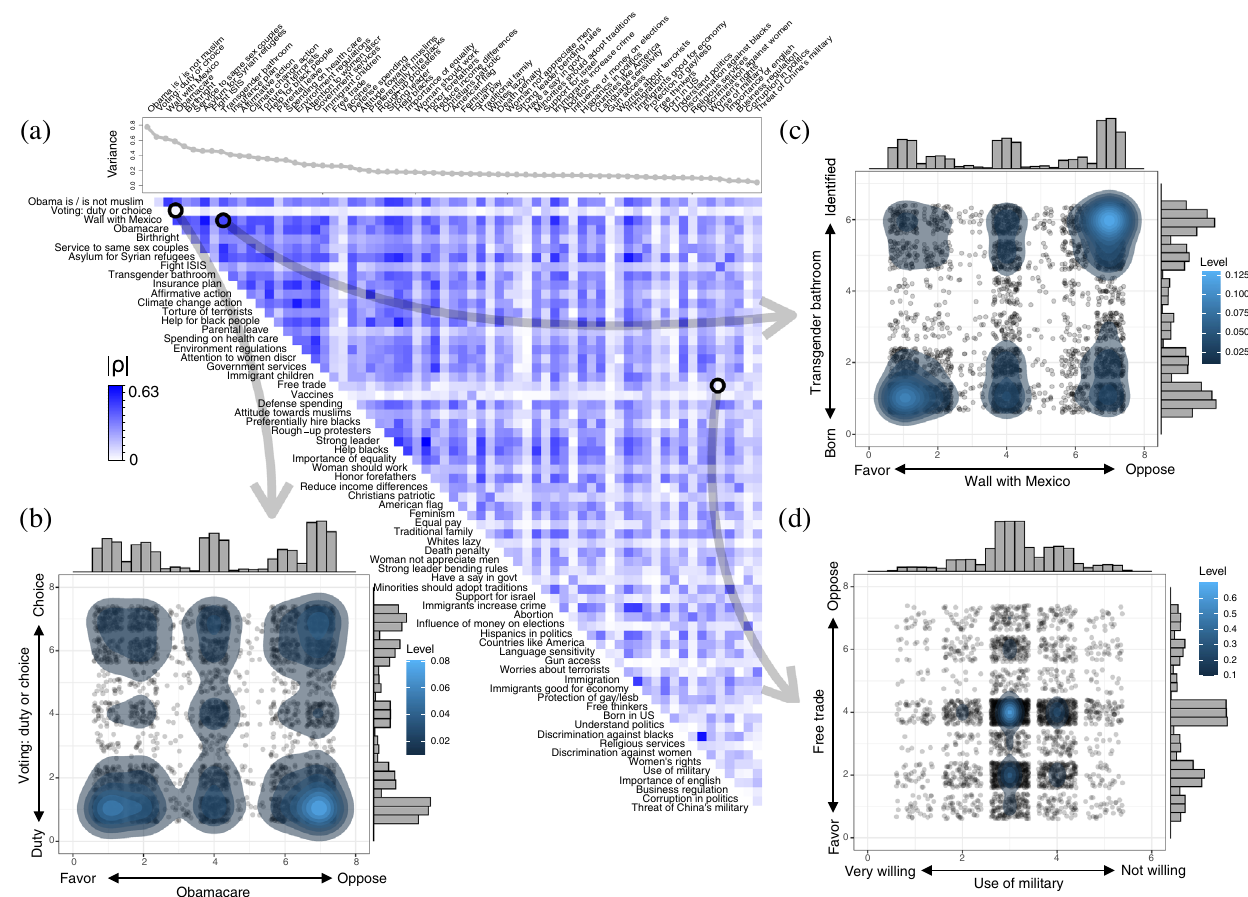
FIG. 6. Responses to questions from the ANES. (a) Variance of all responses and absolute value of pairwise Pearson correlation. (b) – (d) Scatter plots of selected pairs of questions v and z , where each dot represents one respondent by his or her responses to both questions. The marginal plots represent the response distributions P v ð x Þ and P z ð x Þ . To improve the visualization, data are jittered [74], and uniformly distributed noise is applied, to up to 80% of the bin size, to avoid overplotting of the categorical data and at the same time assure discrete separation. The examples are selected to represent different combinations of response variance (opinion polarization) and response correlation: (d) low variance ( σ 2 v ¼ 0 . 08 , σ 2 z ¼ 0 . 25 ) and low correlation [ j ρ ð v; z Þj ¼ 0 . 02 ] for questions V162176x vs V161154, denoting ANES IDs (see Supplemental Material [56] for a complete list of IDs); (b) high variance ( σ 2 v ¼ 0 . 58 , σ 2 z ¼ 0 . 64 ) and low correlation [ j ρ ð v; z Þj ¼ 0 . 03 ] for V161151x vs V161114x; and (c) high variance ( σ 2 v ¼ 0 . 62 , σ 2 z ¼ 0 . 49 ) and high correlation [ j ρ ð v; z Þj ¼ 0 . 44 ] for V161228x vs